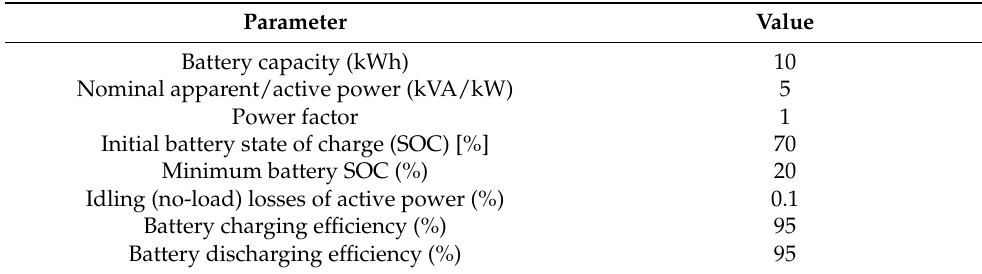
Table 6. Technical characteristics of battery energy storage system (BESS) integrated at the WPF PCC.